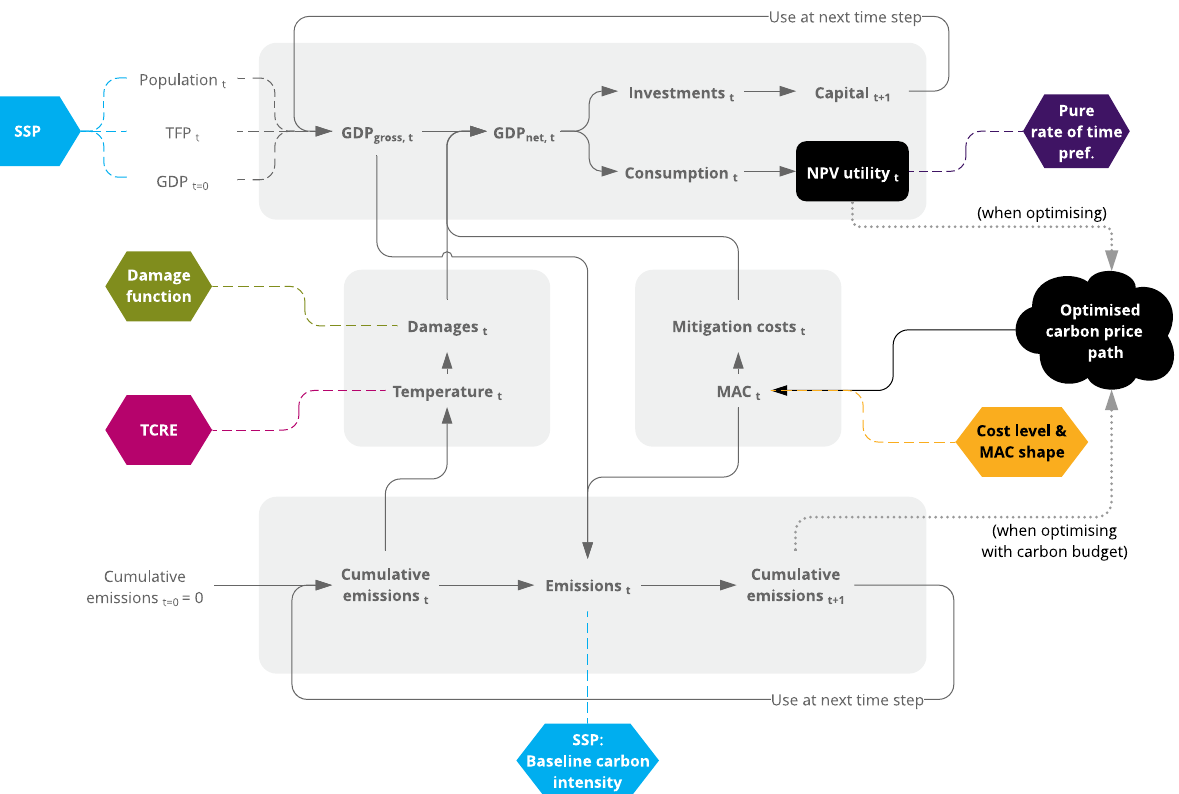
Fig. 1 Schematic representation of the model. The model consists of an economic module (top) with a Cobb-Douglas production function, and an emission module (bottom). The interactions between these two modules occur through damages and mitigation costs. The coloured boxes represent the parameters for which we use a representative range from literature. The carbon price path, in black, is the input variable of the model and the control variable in the optimisation.